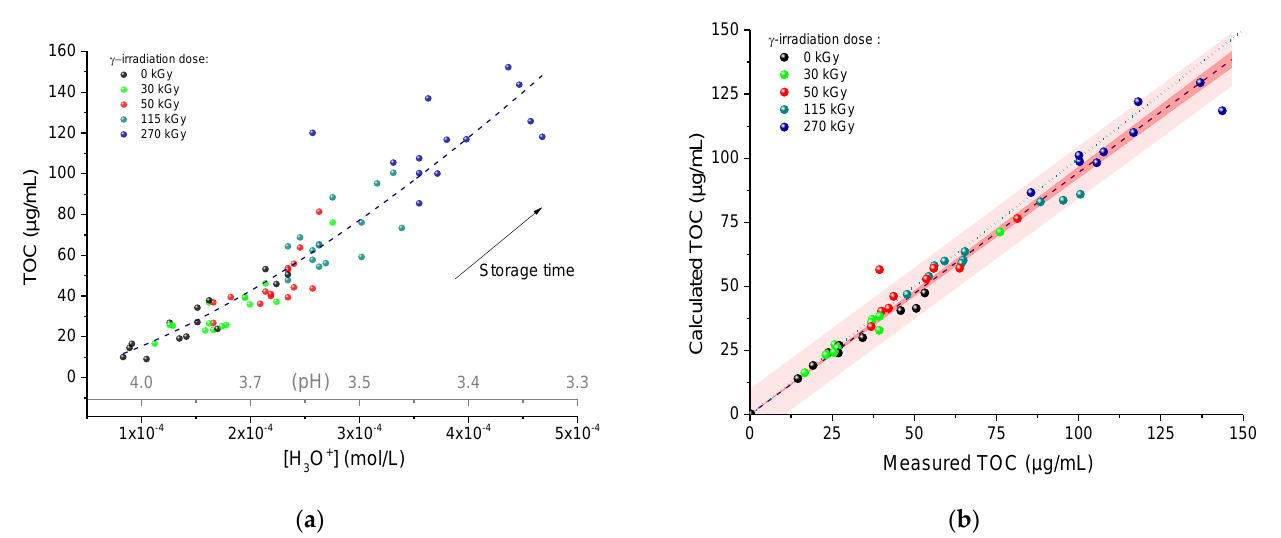
Figure 13. ( a ) TOC vs pH at different irradiation doses in EVA/EVOH/EVA films. Dotted line shows the trend. ( b ) Calcu- lated TOC vs measured TOC at various doses of γ -irradiation in EVA/EVOH/EVA films. The light red band represents 95% prediction band and the dark red band represents 95 % confidence band. The dashed line shows the trend. The dotted line represents the bisector line. Reproduced from [32] with the permission of European Journal of Pharmaceutical Sciences.